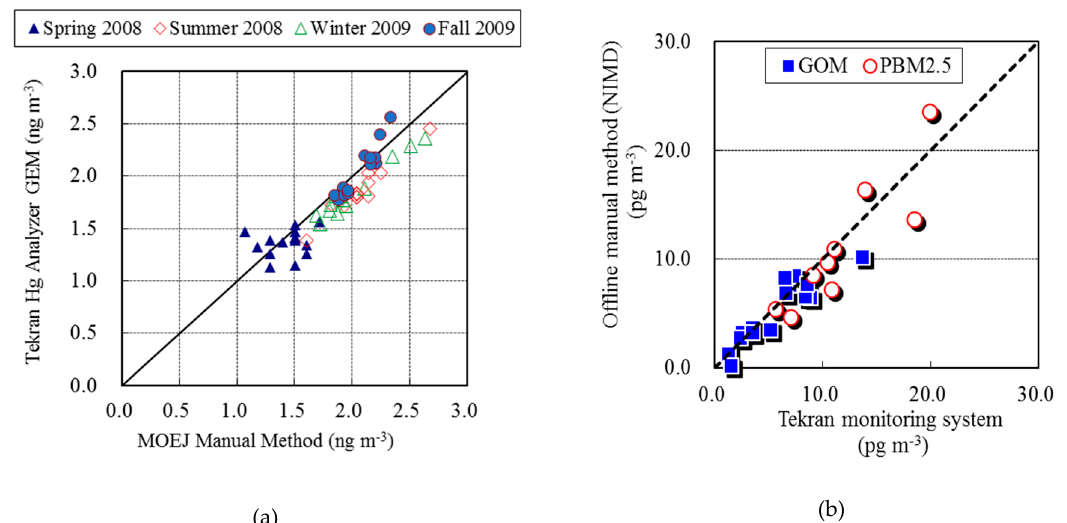
Figure 2. Scatterplots of the ( a ) gaseous elemental mercury (GEM) concentrations recorded using the Tekran monitoring system and the total gaseous mercury (TGM) obtained using the method outlined in the o ffi cial Ministry of the Environment, Japan (MOEJ) manual and ( b ) gaseous oxidized mercury (GOM) and particle-bound mercury for particles with diameter smaller than 2.5 µ m (PBM 2.5 ) concentrations recorded using the Tekran monitoring system and the o ffl ine